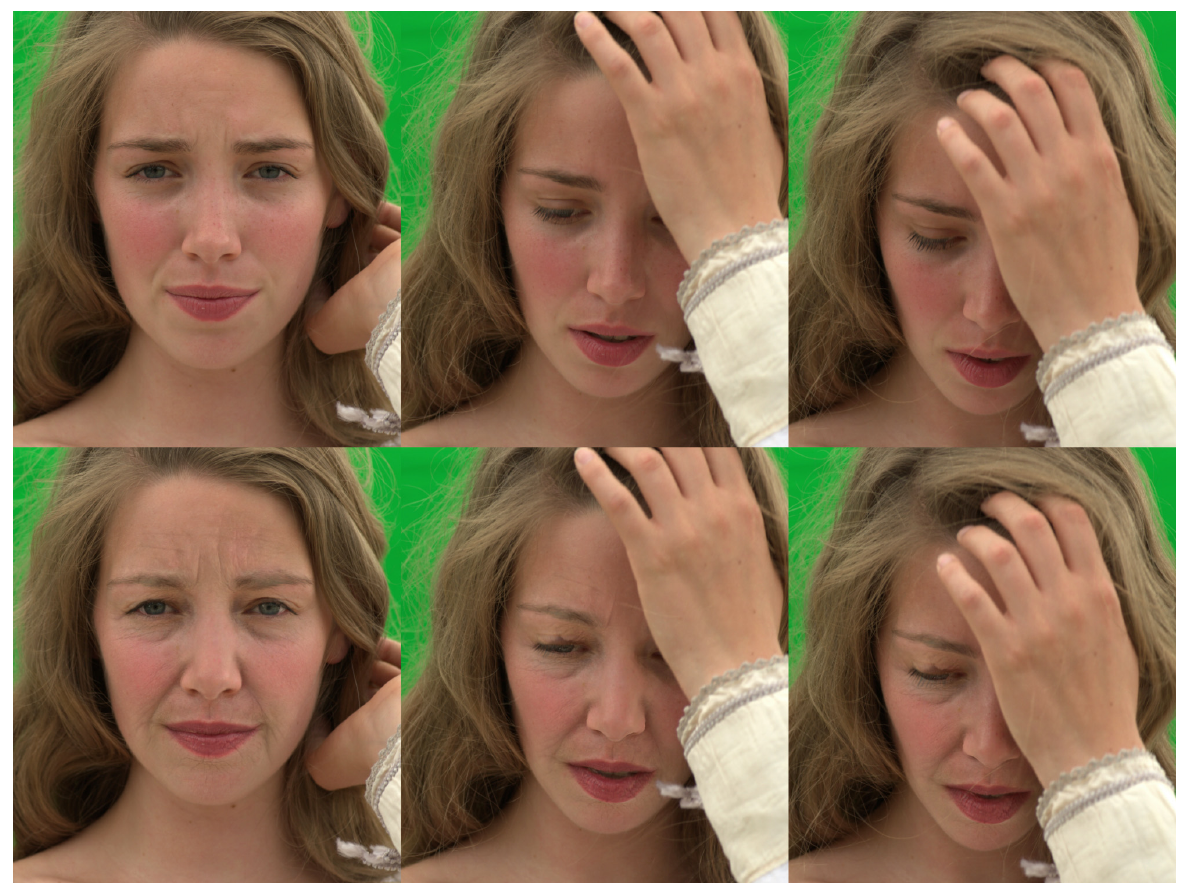
Fig. 12 Samples from the wife sequence (100, 8, and 1) and the same samples including the visual effect.